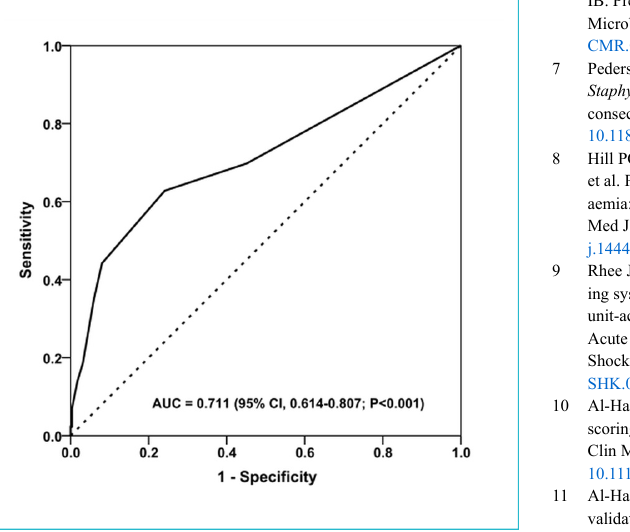
Figure 1: Receiver-operating characteristics curve of the Pitt Bac- teraemia Score for prediction of 30-day all-cause mortality in Staphylococcus aureus bloodstream infection (n =